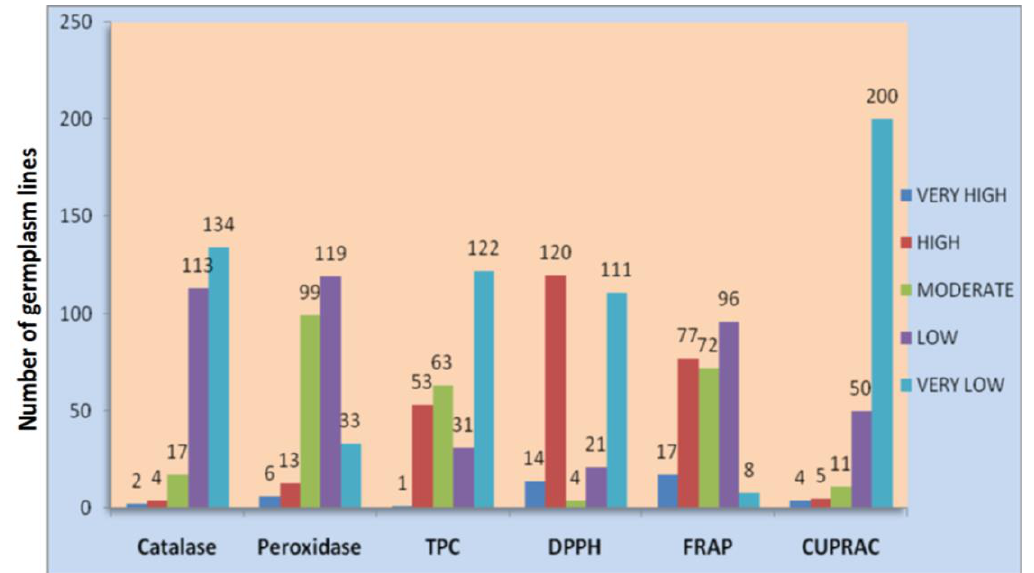
Figure 1. Frequency distribution of genotypes containing each antioxidant trait, namely, catalase, peroxidase, total phenolics content (TPC), 2,2-diphenyl-1-picrylhydrazyl (DPPH), ferric reducing antioxidant power (FRAP) and cupric ion reducing antioxidant capacity (CUPRAC) in the 270 shortlisted germplasm lines. Table 1. Mean values of catalase (unit min − 1 g − 1 ), peroxidase (unit min − 1 g − 1 ), TPC (mg CE100 g − 1 ), DPPH (% inhibition), FRAP (AAE g − 1 ) and CUPRAC (TE g − 1 ) antioxidant traits estimated from the 117 genotypes present in the panel